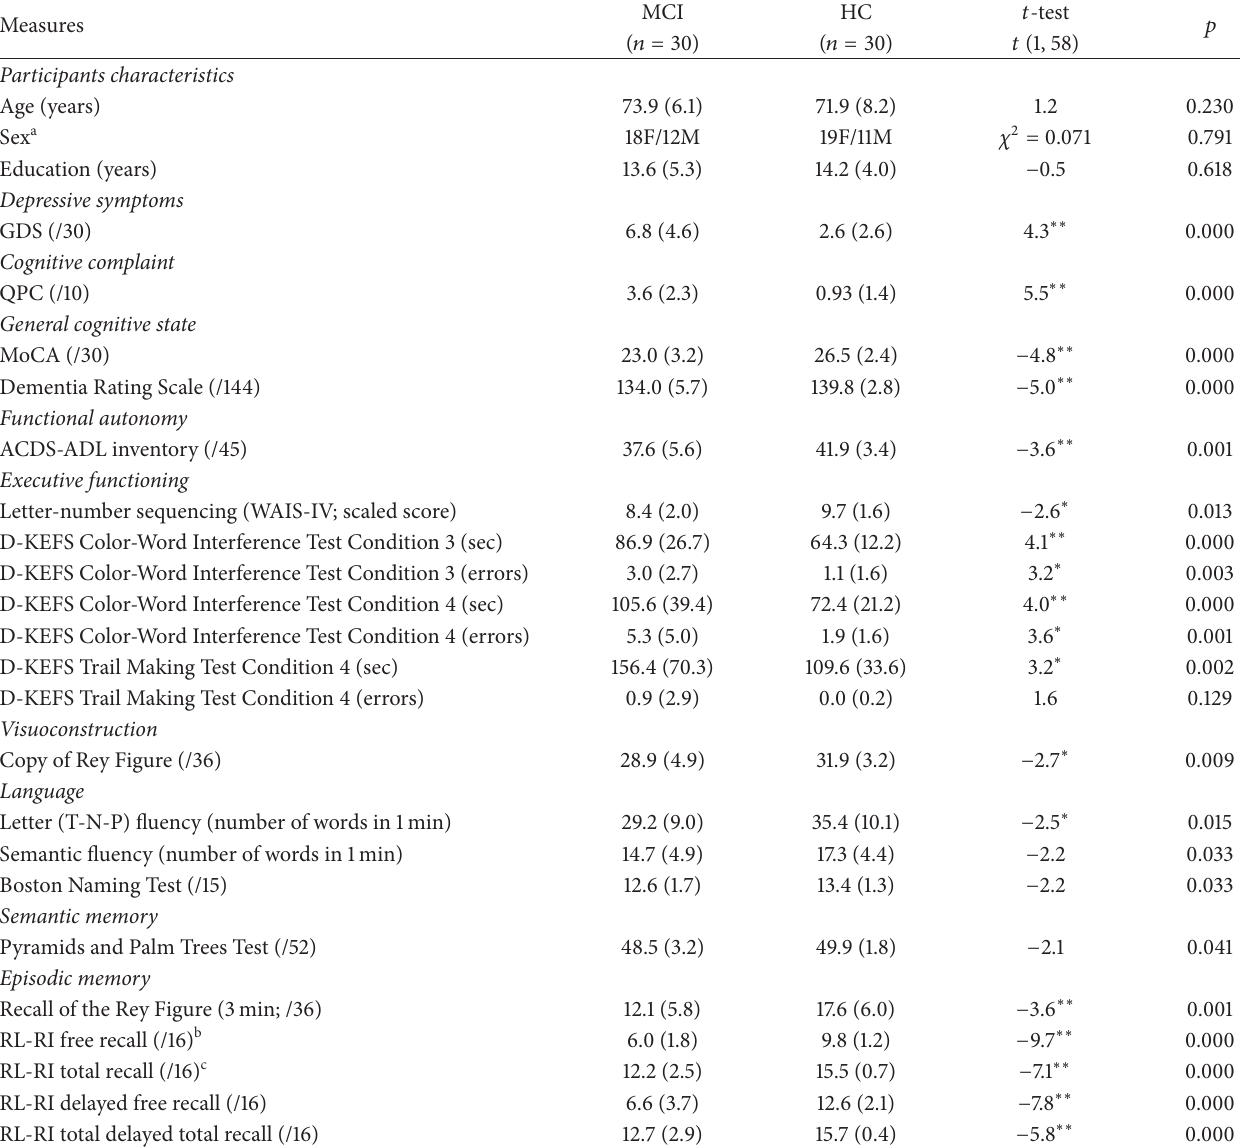
Table 1: Mean (SD) and significance levels of demographic and neuropsychological characteristics of